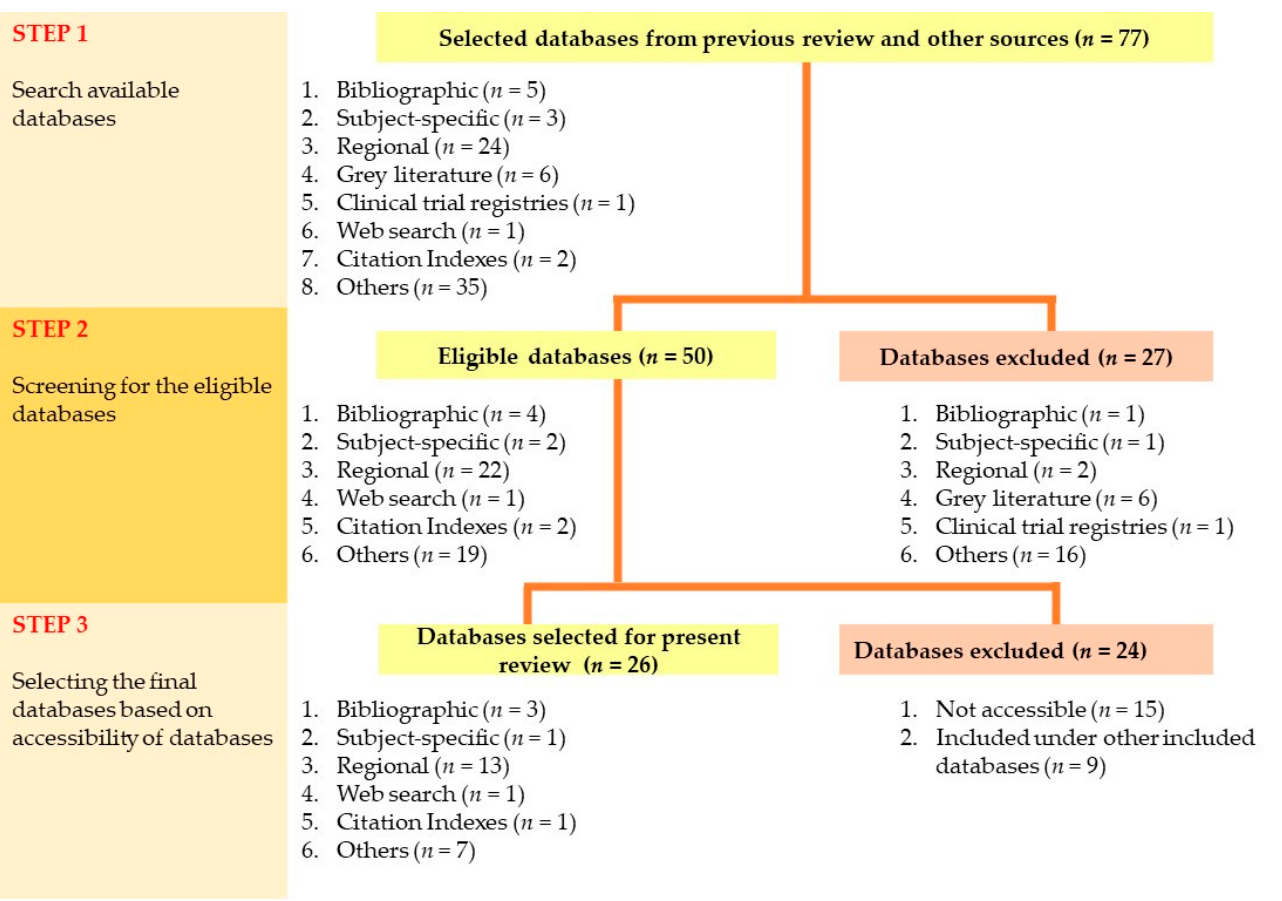
Figure 5. Summary of results at each stage of selecting databases for the present review.